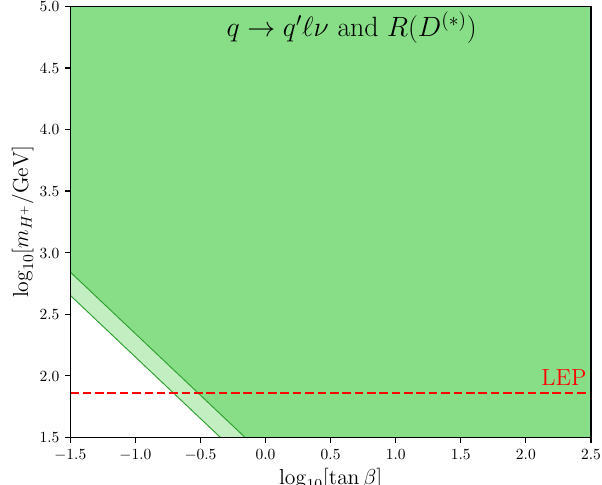
Figure 3 . Contour plot of the allowed 2HDM-I parameter space in the ( tan β − m the combination of tree-level leptonic and semi-leptonic decays of B, B s , D, D s , K , and π mesons and the hadronic decays of τ leptons to K and π mesons with a tau neutrino as well as R ( D ) and R ( D ∗ ) . The lighter contour indicates the allowed parameter space at 2 σ confidence level while the darker contour corresponds to 1 σ . The red dashed line indicates the LEP lower bound for m the Type I 2HDM ( 72 . 5 GeV).